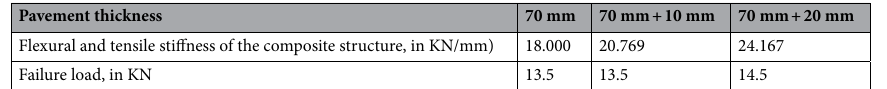
Pavement thickness Flexural and tensile stiffness of the composite structure, in